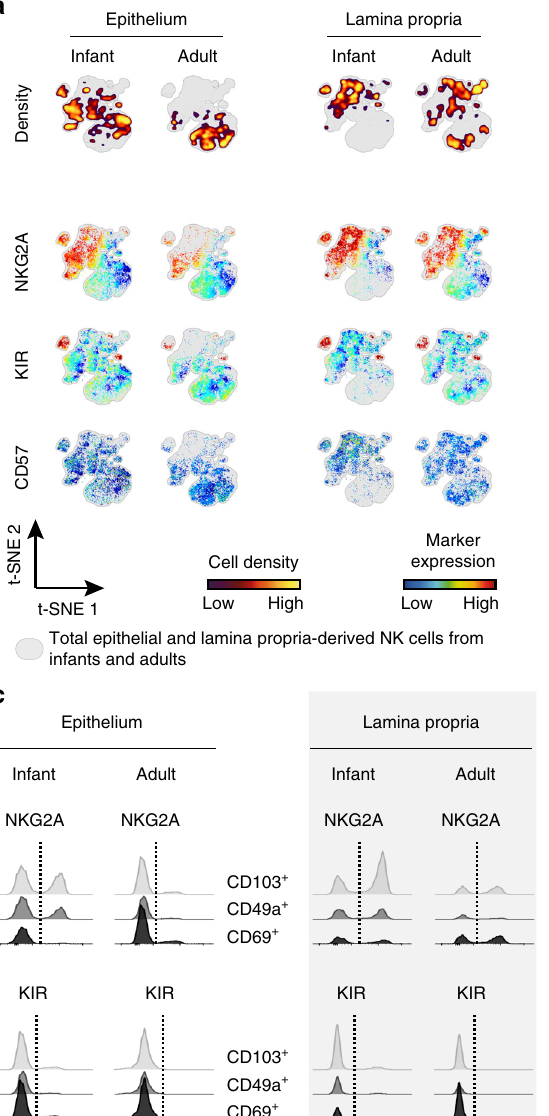
granzyme B and perforin in infant CD69 + NK cells compared to CD103 + NK cells was not observed for adult epithelial NK cells, as almost all adult epithelial NK cells were double positive for CD103 and CD69 (Fig. 3b). However, adult CD103 + NK cells and CD69 + NK cells were present in the lamina propria and a